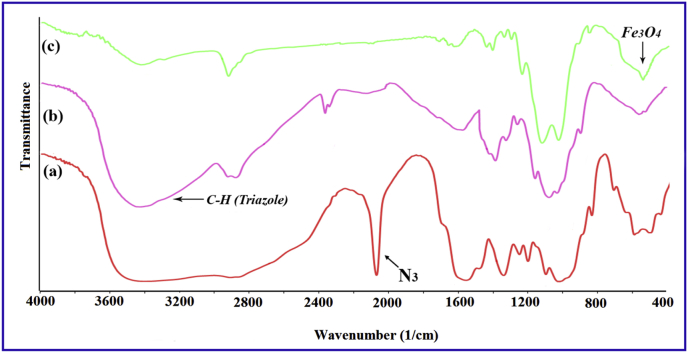
FT-IR spectra of a) azidated chitosan, b) chitosan-silane composite, c) chitosan-silane clicked @ Fe3O4.